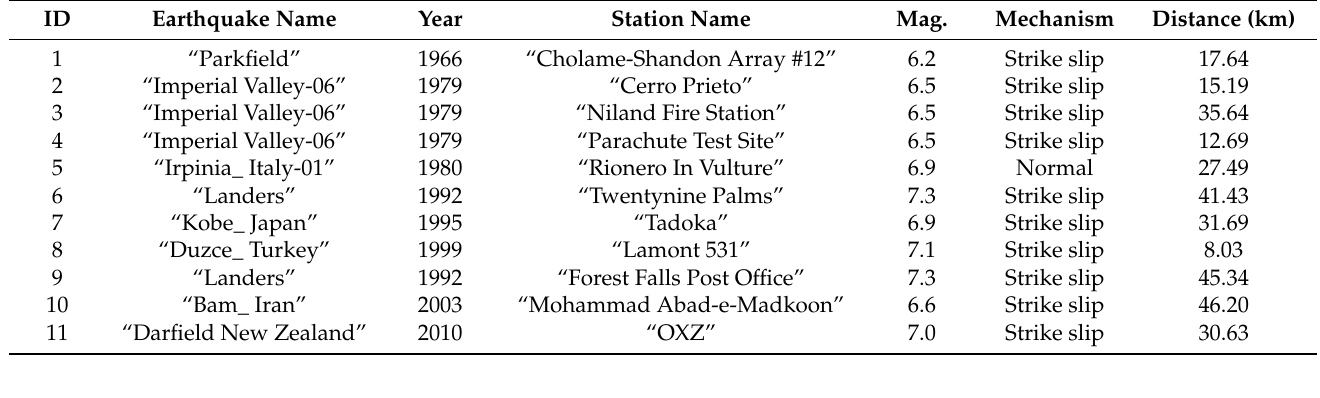
Table 3. Earthquake records used in the analysis (PEER, 2021).